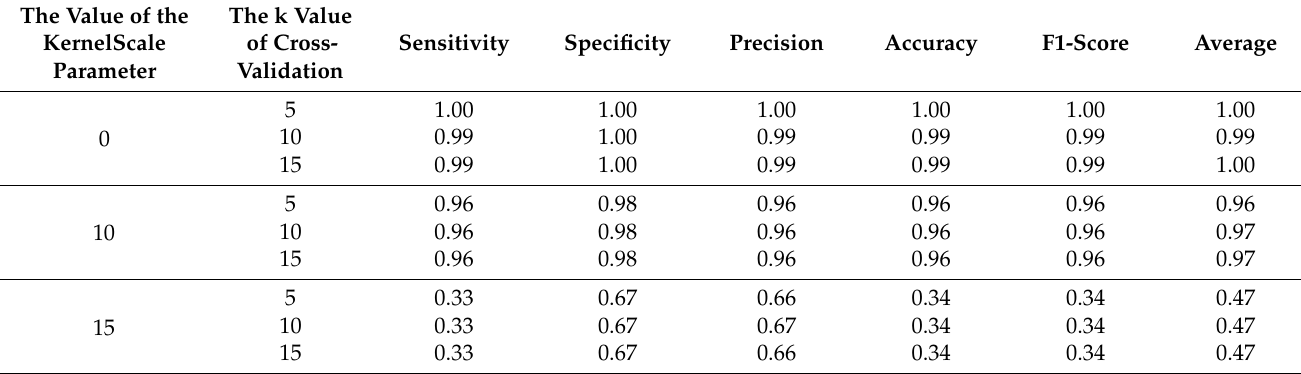
Table 2. Results of calculating diagnostic test value measures for SVM support vector machine.